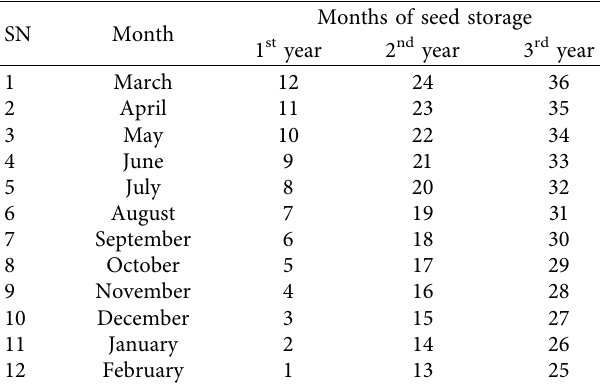
Table 1: Treatments used to study the effect of storage durations on seed viability of tagasaste after seed treatment using boiling